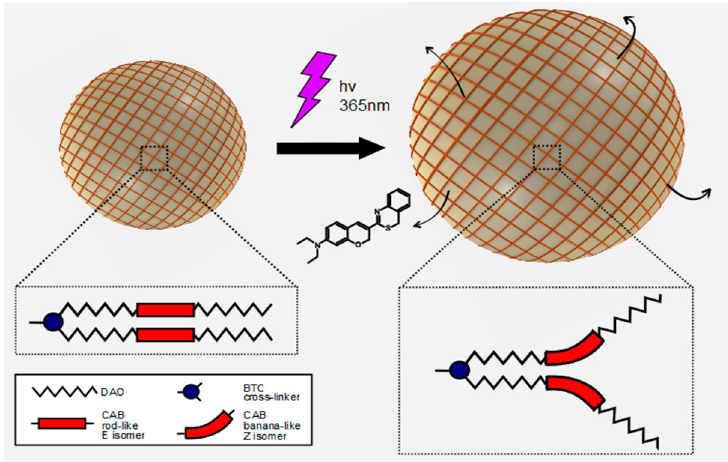
Figure 2. Schematization of the C6 release from photo-responsive polymer nanocapsules as depicted by Marturano et al. [34]. Reproduced with permission from Elsevier.